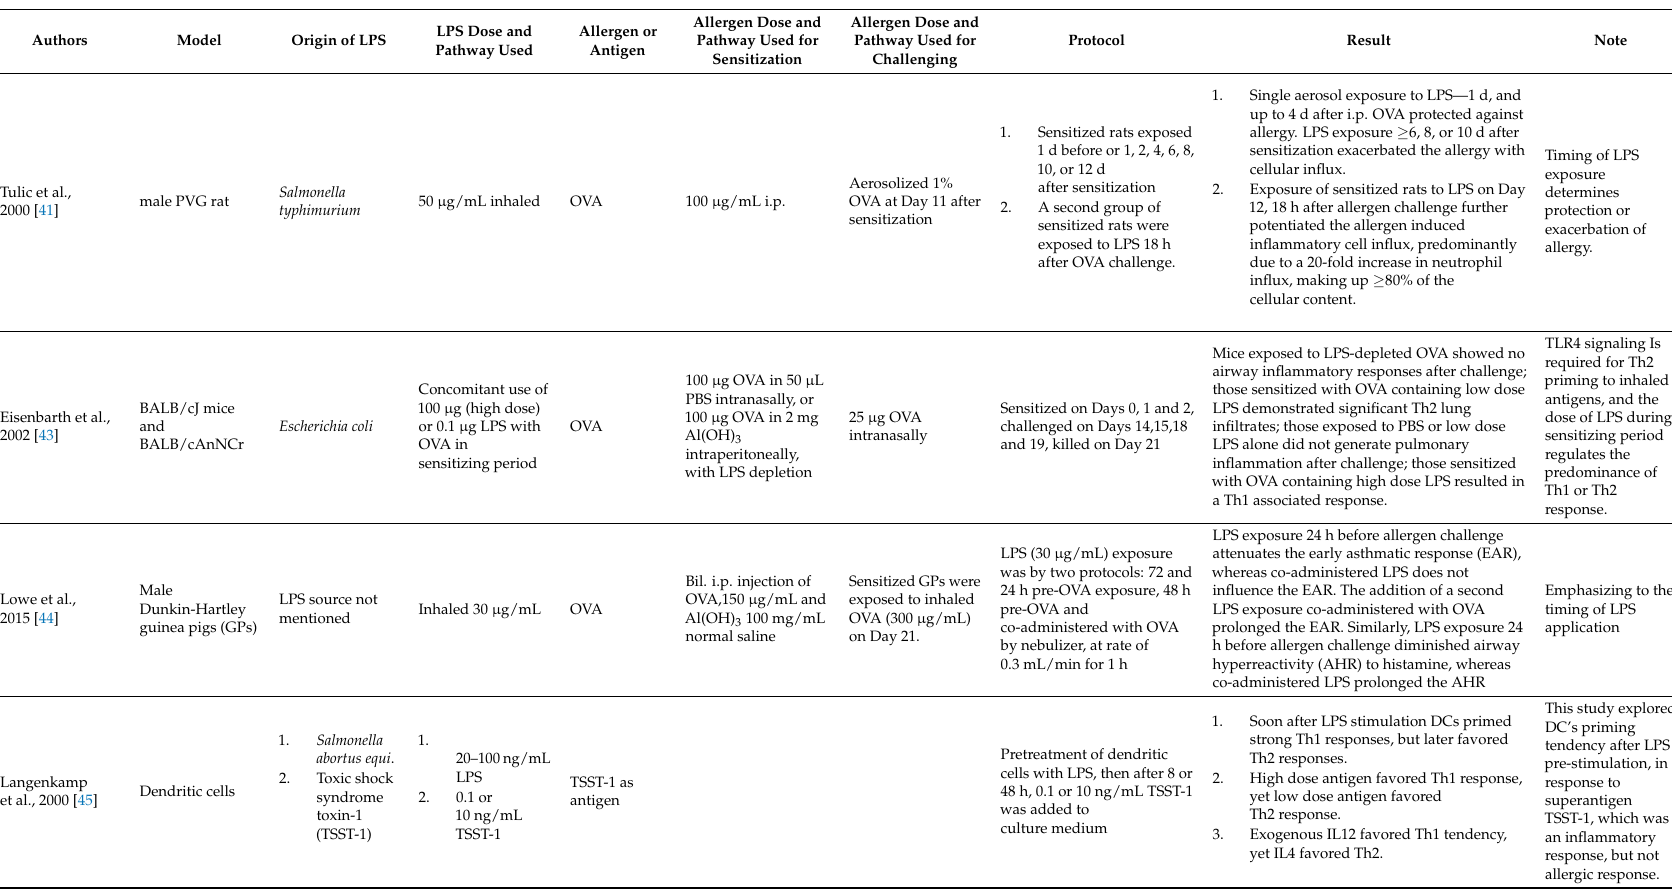
Table 1. Studies demonstrating the biphasic capacity of lipopolysaccharides